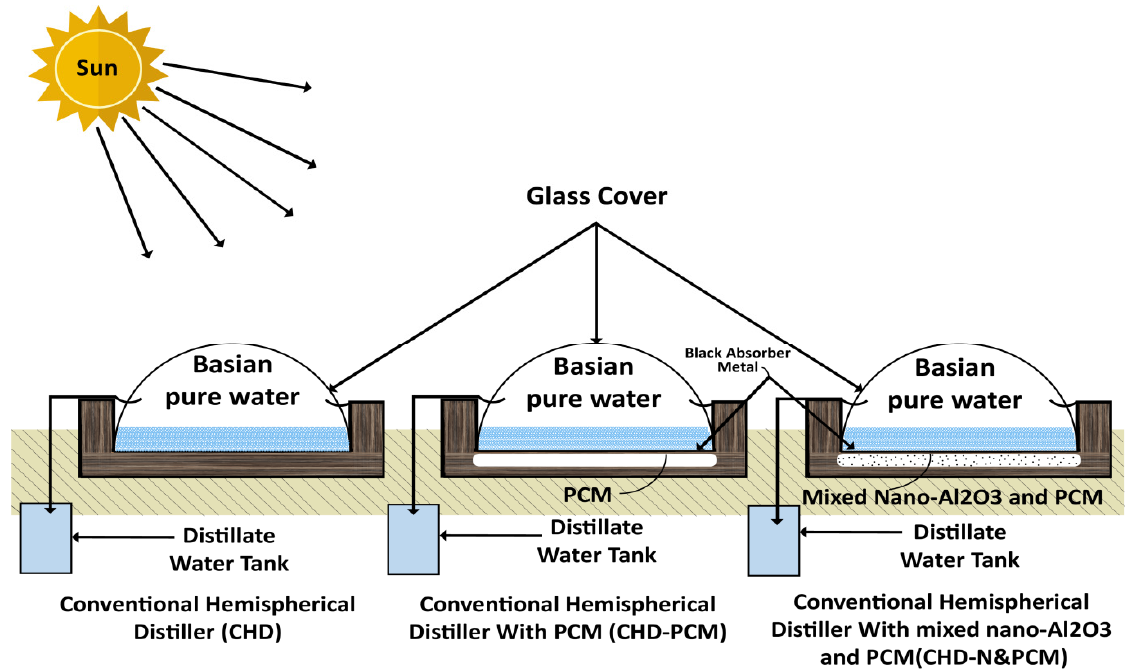
Figure 4. Graphical representation of the different configurations of hemispherical solar still.